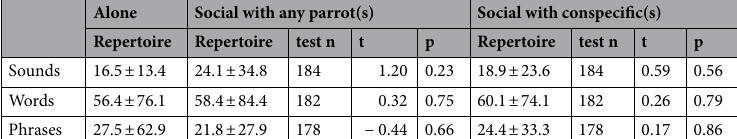
Alone Social with any parrot(s) Social with